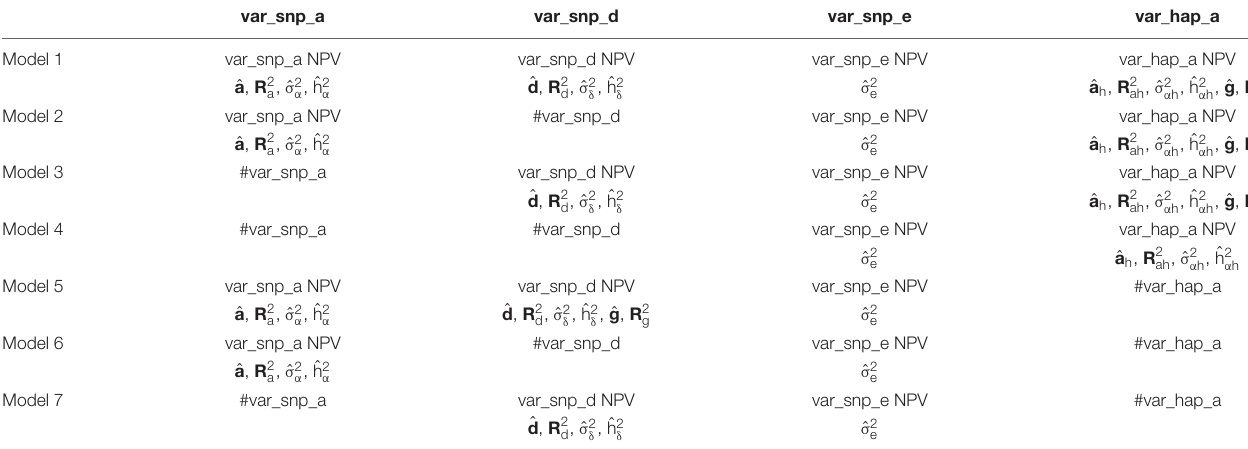
TABLE 1 | Seven prediction models configured by parameters for starting values of variance components in the parameter file and the main results of GBLUP and GREML for each model.